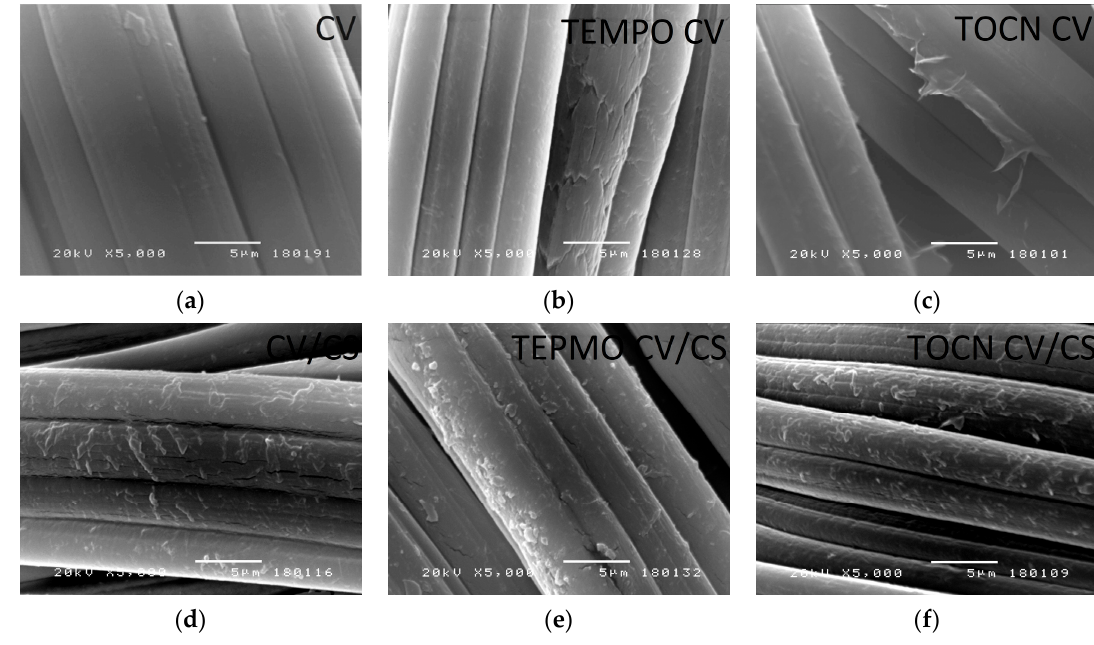
Figure 3. SEM images of pristine viscose (CV) ( a ), TEMPO oxidized CV (TEMPO CV) ( b ), TOCN coated CV (TOCN CV) ( c ), chitosan coated CV (CV/CS) ( d ), chitosan coated TEMPO oxidized CV (TEMPO CV/CS) ( e ) and chitosan coated TOCN CV (TOCN CV/CS) ( f ).